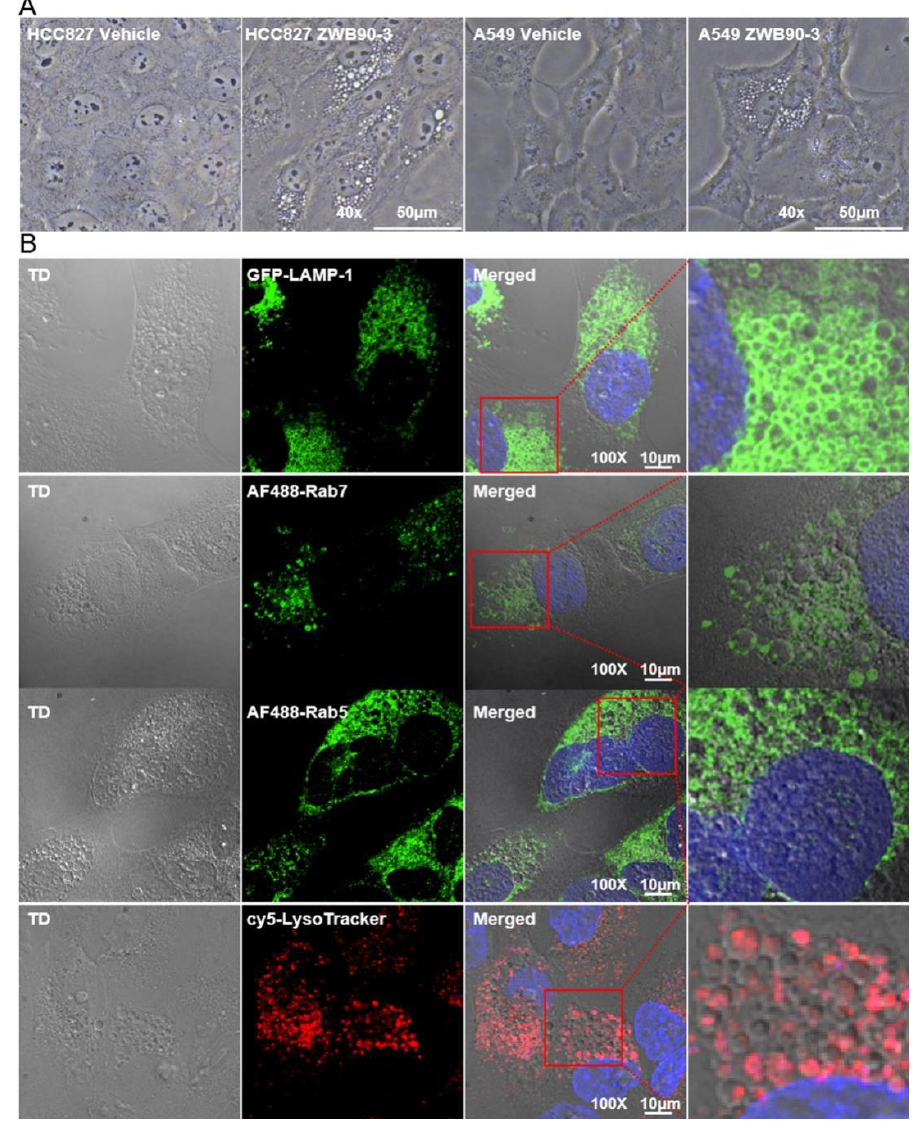
Figure 5. ZWB90-3-induced large vacuole formation in HCC827 and A549 cells. ( A ) Phase contrast images were taken after 72 h of ZWB90-3 or PBS treatment (vehicle) in HCC827 and A549 cells. Images were acquired at 40 × magnification. Scale bars: 50 µ m. ( B ) HCC827 cells were treated with ZWB90-3 to induce vacuole formation. Confocal imaging was used to co-localize GFP-LAMP1, AF488-Rab7, AF488-Rab5, and cy5-LysoTracker. Images were acquired at 100 × magnification. Scale bars: 10 µ